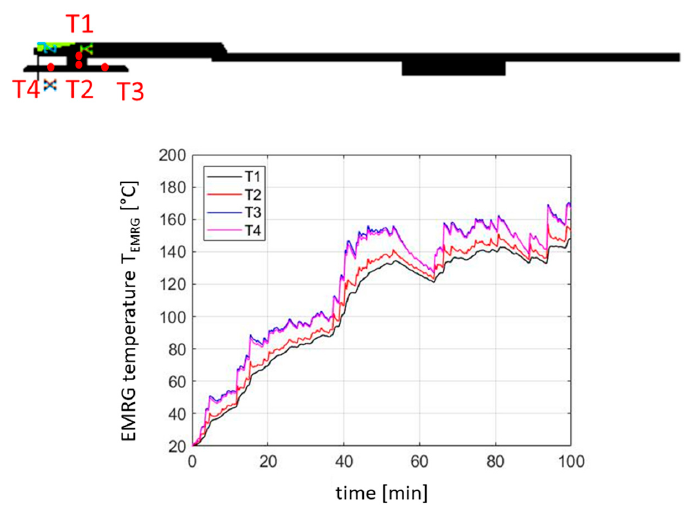
Figure 18. Time evolution of EMRG